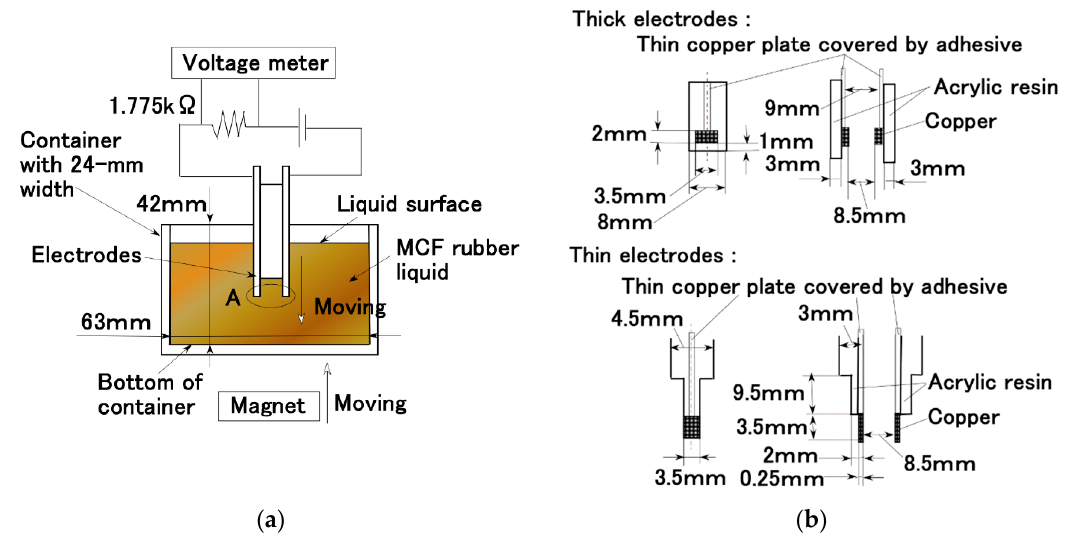
Figure 1. Schematic of experimental apparatus to investigate the effect of particle aggregation by the application of a magnetic field on the magnetic compound fluid (MCF) rubber liquid: ( a ) Overall diagram; ( b ) detailed diagram of electrodes denoted as A in ( a ).